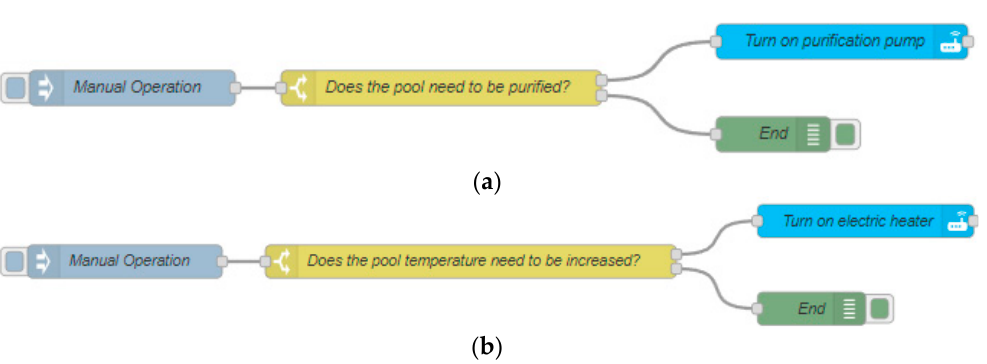
Figure 4. ( a ) Purification flowchart. ( b ) Swimming pool heating flow chart.